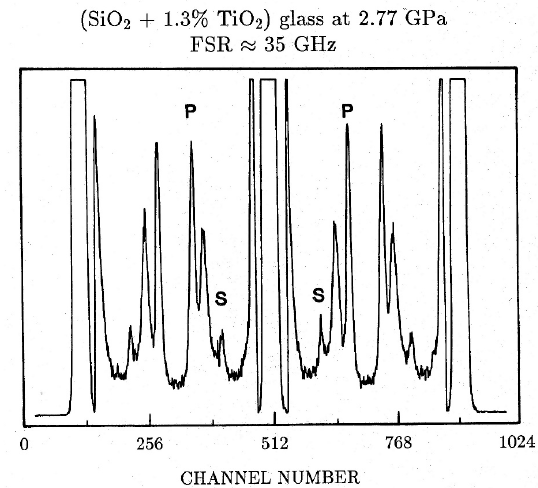
Figure 5. Representative Brillouin spectrum of an SiO 2 –TiO 2 glass at 2.77 GPa; P and S represent compressional and shear peaks, respectively. Peaks generated by different orders of the grating are also present, as is a peak produced from the pressure medium between the P and S peaks. The higher signal-to-noise of the compressional peak relative to the shear peak produces a smaller error bar for the compressional velocity determination relative to the shear velocity.